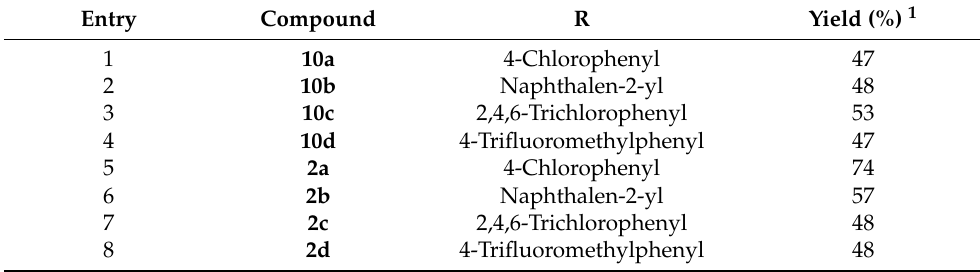
Table 3. Experimental data of compounds 8a – d and 10a – d .